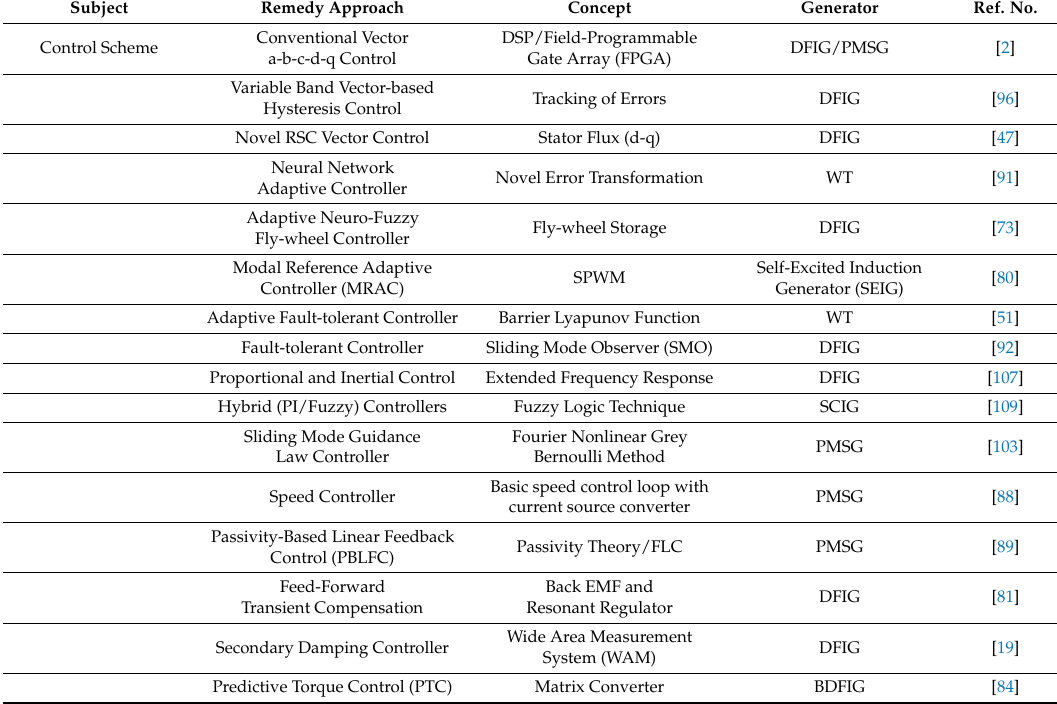
Table 4. Summary of various control/protection techniques for mitigating and managing transient faults. FLC, fuzzy logic controller; EMF, electromotive force; WPT, wavelet packet transform; DGU, distributed generation unit; HVDC, high-voltage direct